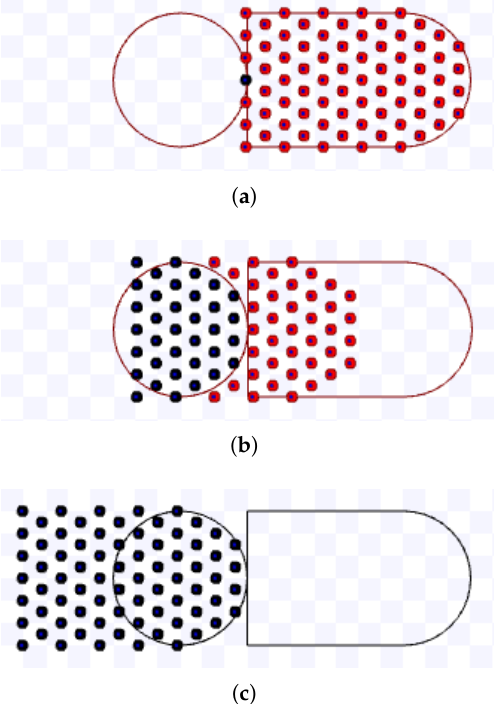
Figure 28. Simulation on Stage for hexagonal packing strategy using s = 3 m, θ = π / 6 during T = 10 s. Available on https://youtu.be/szOBU8no_sU, accessed on 12 June 2022. ( a ) 0 s: beginning of the simulation; ( b ) After 4.9 s; ( c ) 10 s: ending of the simulation.